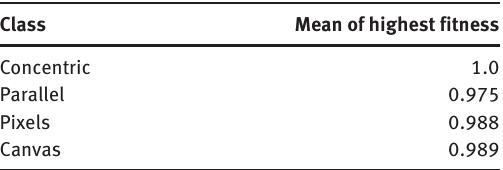
Table 2: The Mean of the Highest Fitness Achieved for Each